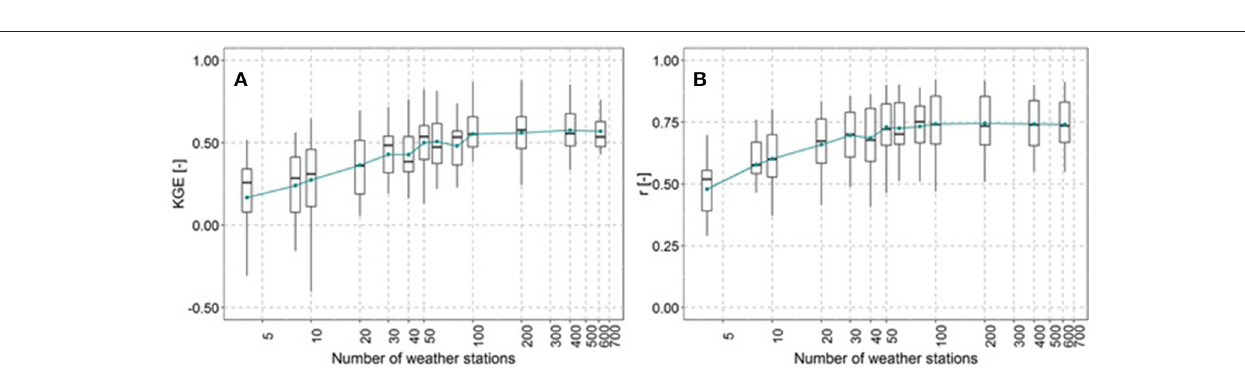
FIGURE 12 | (A) KGE and (B) r values (y-axis) between daily simulated and observed discharge when the model was forced with in situ interpolated precipitation at 1km resolution for the 2000–2012 period, derived with different number of weather stations (x-axis; 4, 8, 10, 20, 30, 40, 50, 60, 80, 100, 200, 400, and 616). Logarithmic scale was used for the horizontal